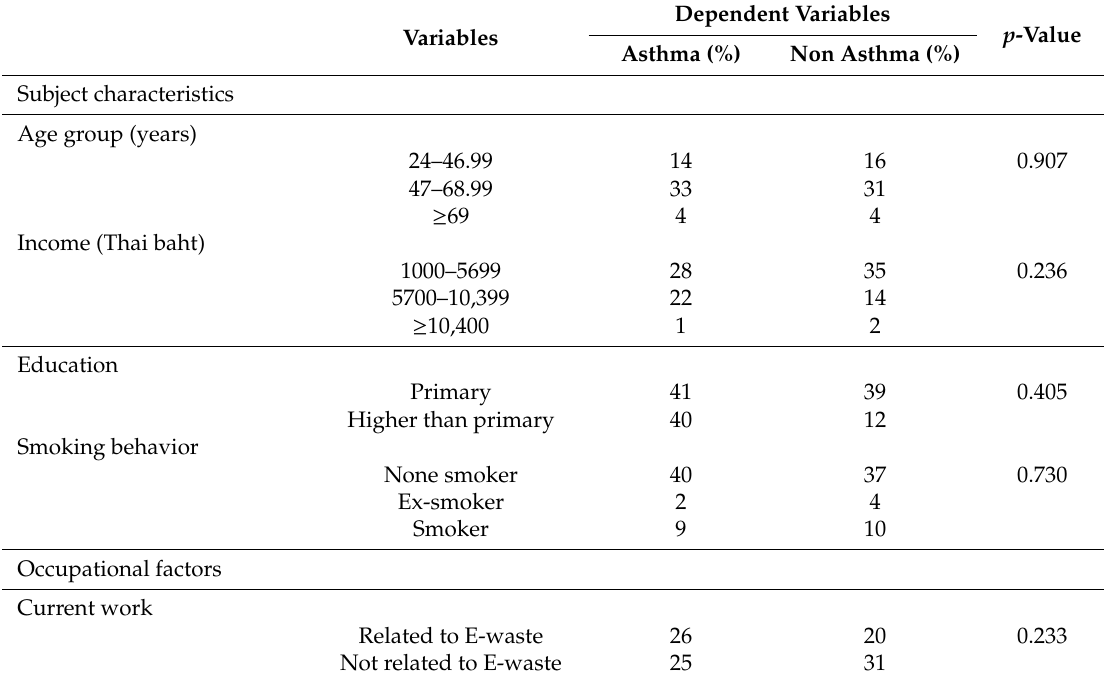
Table 8. Association of personal and occupational characteristics and asthma in study participants.